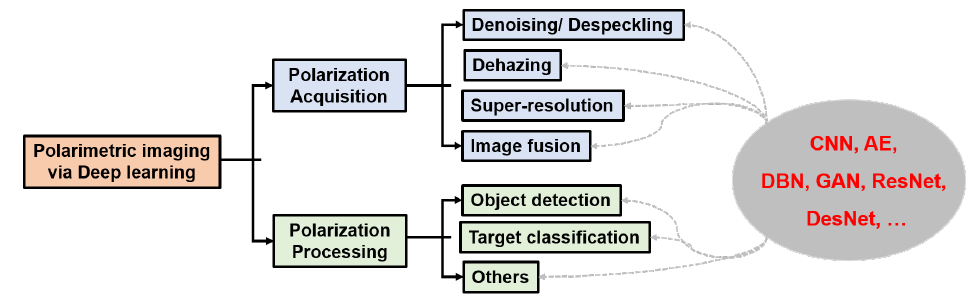
Figure 11. Brief outline of Sections 4 and 5.